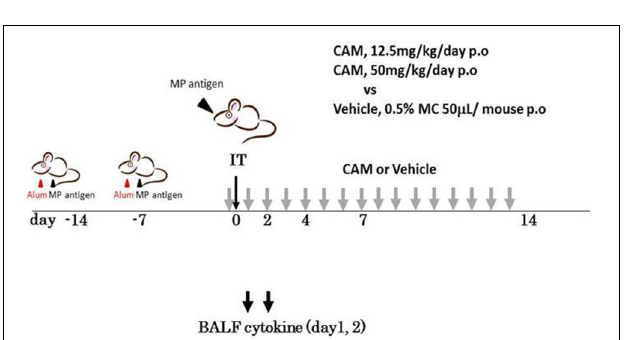
FIGURE 9 | Model E, the clarithromycin (CAM)-treated murine model. Just before intratracheal challenge (IT) with Mp antigen, mice were divided into 3 treatment regimen groups. All were orally treated once a day with CAM (12.5mg/kg/day or 25mg/kg/day) or vehicle for 2 consecutive weeks. CAM, clarithromycin; IT, intratracheal challenge; P.O, per os; BALF, bronchial alveolar lavage fluid.